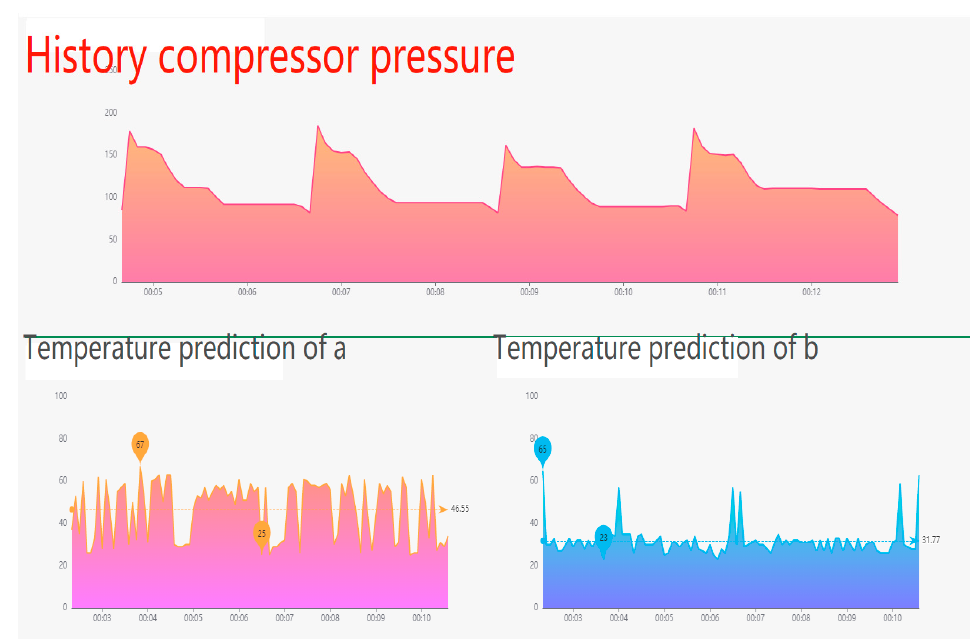
Figure 5. Predicted values for various devices.